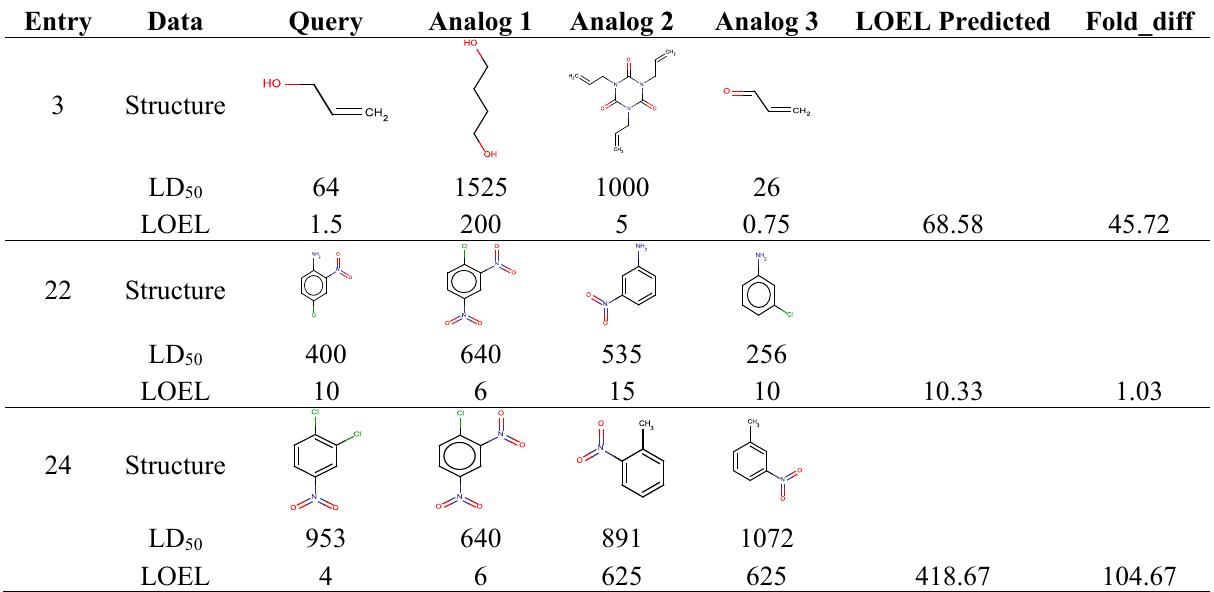
Table 6. Test set query categories with their 3 respective